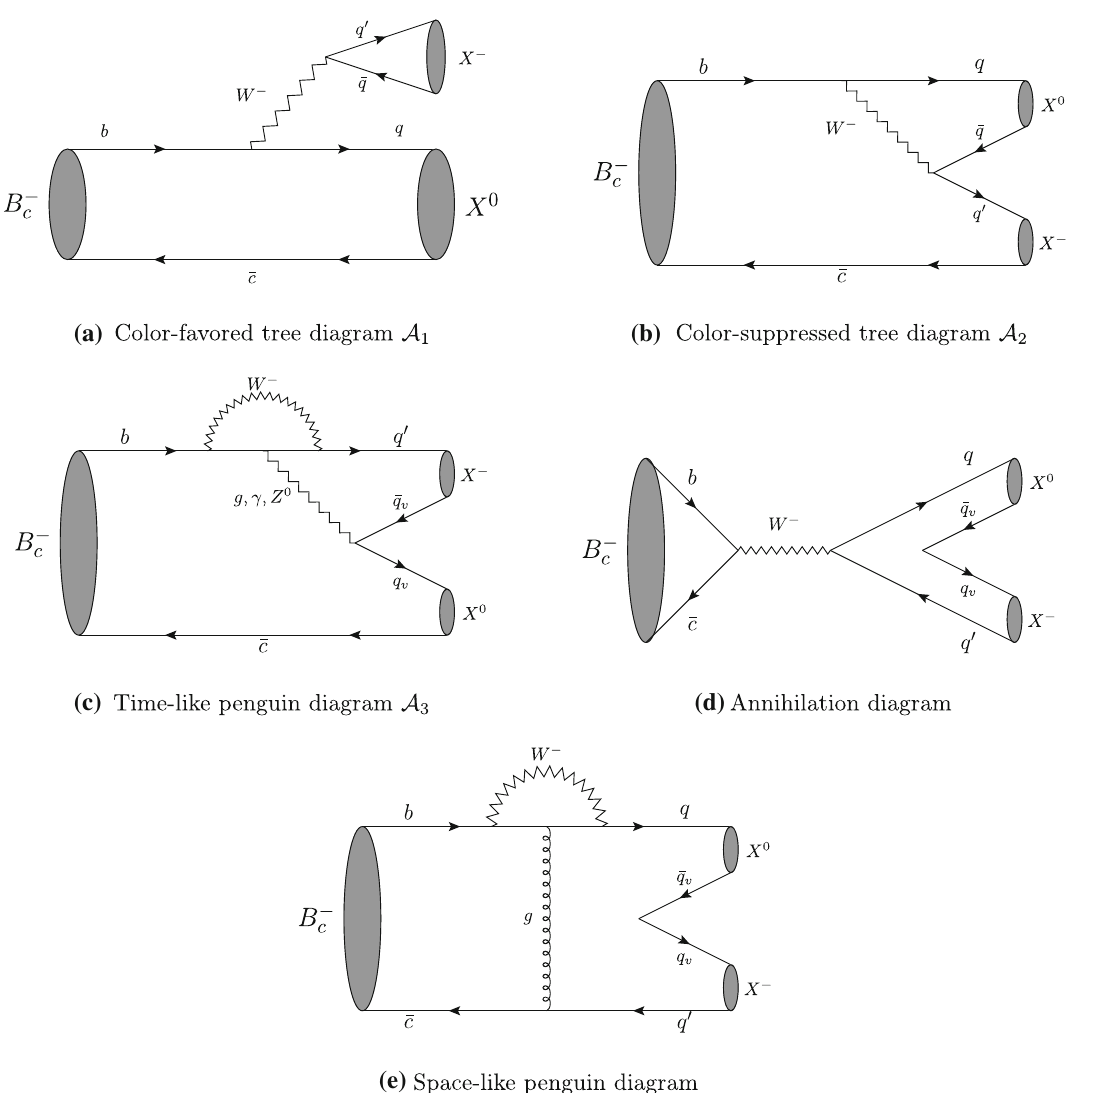
Fig. 1 TheFeynmandiagramsfor B − c decayingintotwomesons X 0 and X − inthespectatorapproximation,where q , q v = u , c and q (cid:4) , q (cid:4) v = d , s